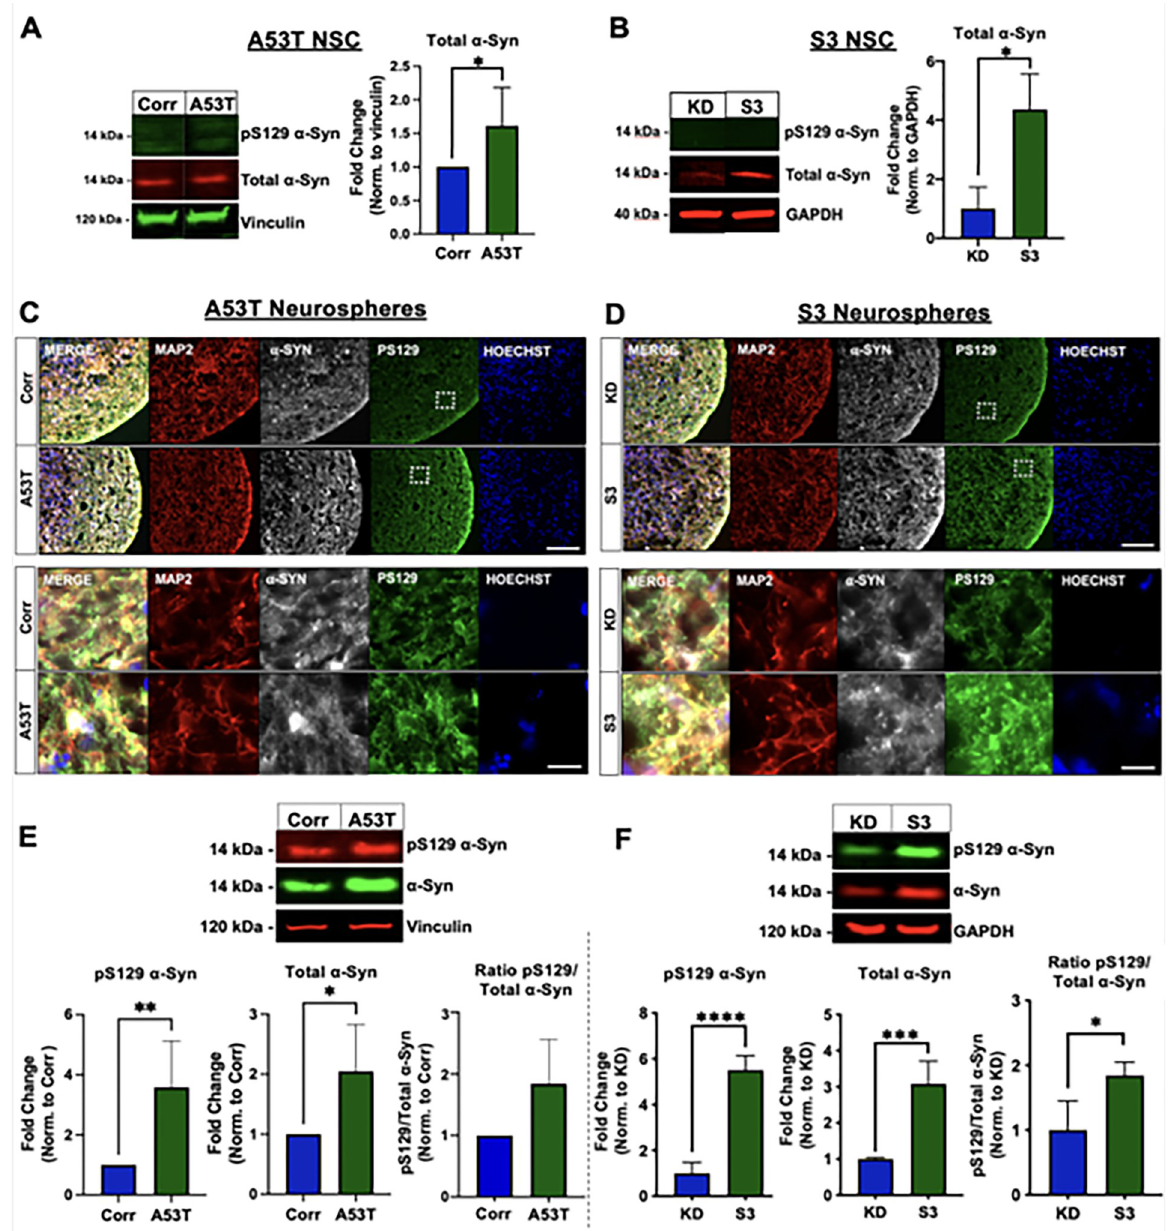
Fig 4. Total and pS129 α -synuclein in NSC and neurospheres. A and B ) Representative Western blot for pS129 and total α -synuclein (left panels) and quantification (right panels) for total α -synuclein in the A53T/Corr NSC ( A ) and S3/KD NSC ( B ). C and D ) Immunostaining of neurospheres at day 54 for MAP2, α -synuclein, pS129, and Hoechst. ( C ) A53T/Corr neurosphere view at low magnification (top, scale bar: 100 μ m) and high magnification (bottom, scale bar: 25 μ m). ( D ). S3/KD neurosphere view at low magnification (top, scale bar: 100 μ m) and high magnification (bottom, scale bar: 25 μ m). E and F ) Representative Western blot (top panels) and quantification (bottom panels) for pS129, total α -synuclein, and pS129/total α -synuclein ratio for A53T/Corr ( E ) and S3/KD ( F ) neurospheres at day 54. For the NSC total α -synuclein quantification, n = 6 for A53T/Corr ( A ) and n = 3 for S3/KD ( B ). The neurosphere quantification data is an aggregate of five separate differentiations for the A53T/Corr lines ( E ), and three separate differentiations for the S3/KD lines ( F ). The S3/KD differentiations have two biological replicates within the differentiations (total 6 biological replicates), which result in error bars in the control groups, whereas the A53T/ Corr groups do not. Data is mean + standard deviation and analyzed by a two-tailed Student’s t-test. ( � P < 0.05; �� P < 0.01; ��� P < 0.005; ���� P <